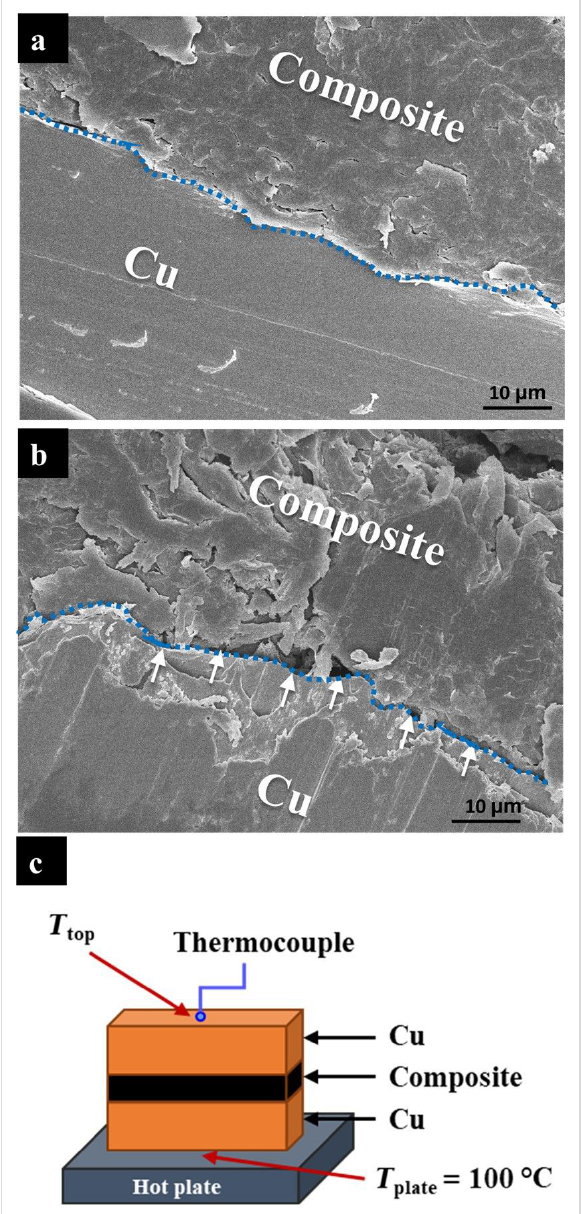
Figure 6: SEM micrographs of the copper–composite interfaces in (a) the lower viscosity system (sample X, 2 vol % GNP and 16 vol % graphite) and (b) the higher viscosity system (sample Y, 6 vol % GNPs and 6 vol % graphite), both with the same TC (see Figure 5). The defects at the interface are indicated with white arrows in (b). (c) Scheme of the measuring system used for the functional tests.